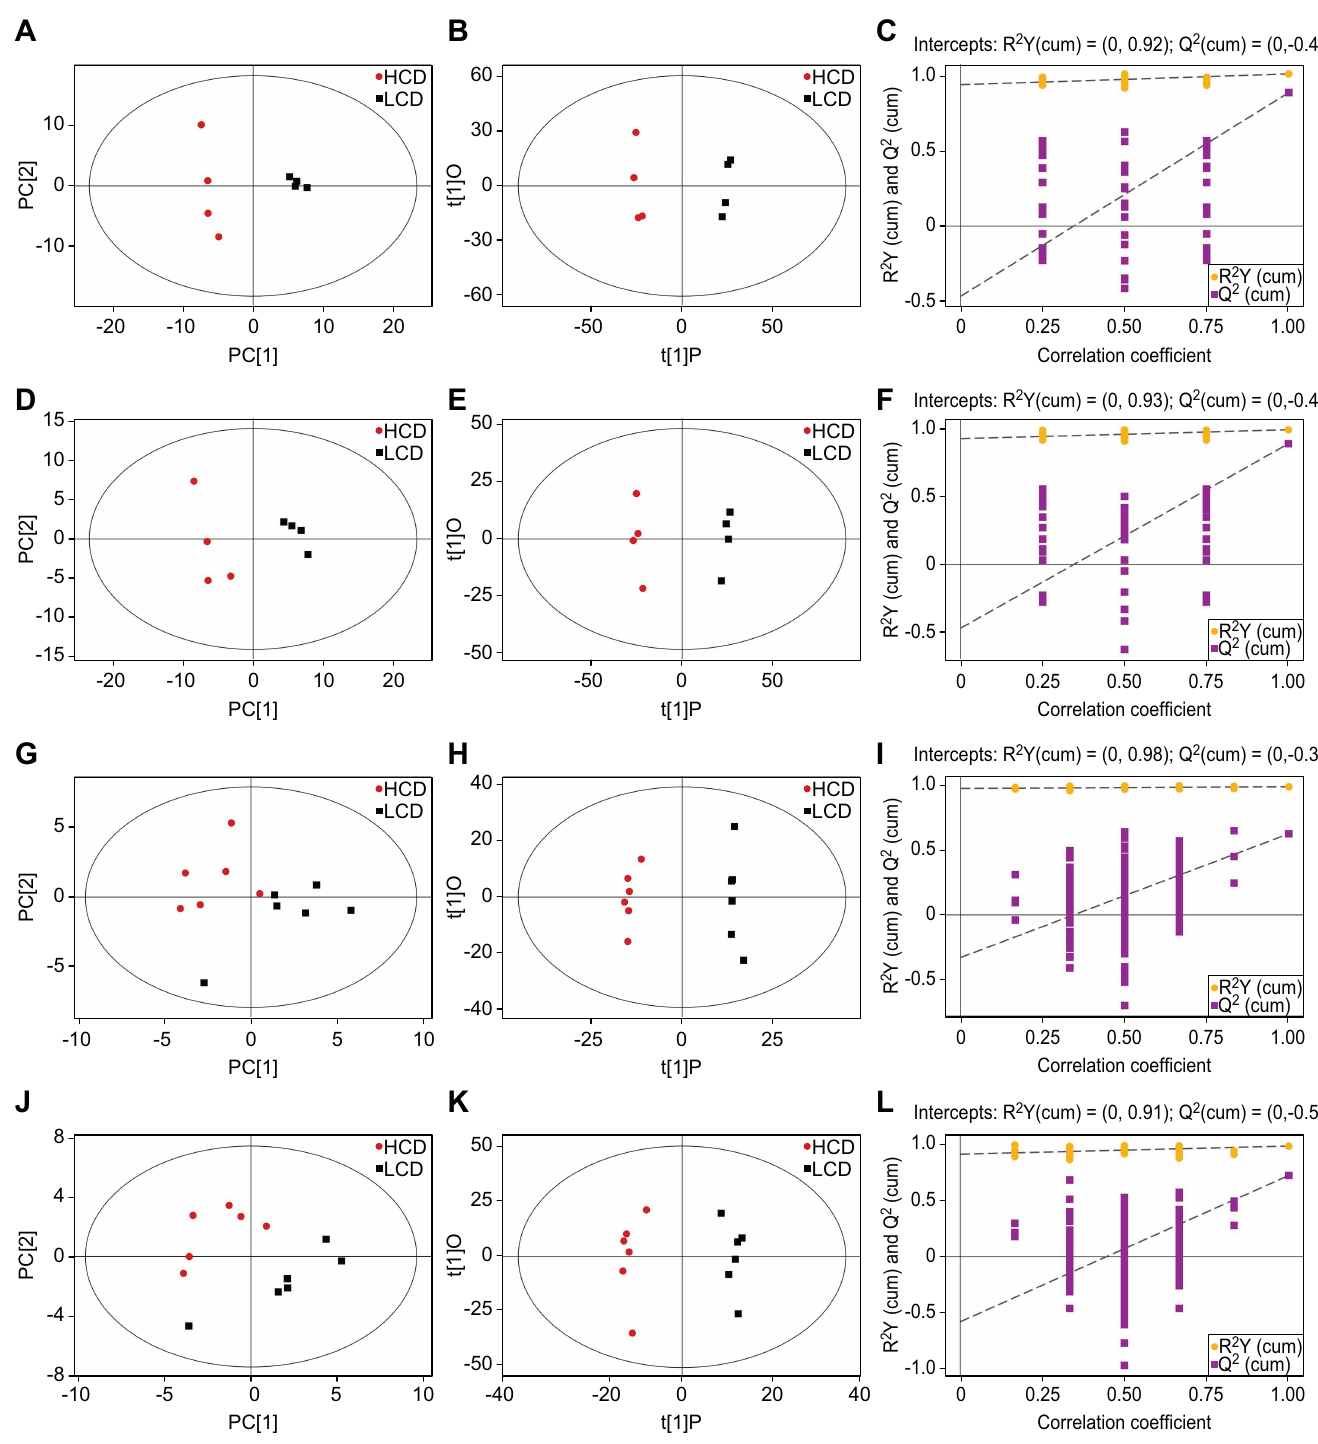
Fig 1. PCA model score scatter plot, OPLS-DA model and permutation test for the LCD vs . HCD groups. The PCA model (A, D, G and J), OPLS-DA model (B, E, H and K) and permutation test of the OPLS-DA model (C, F, I and L) were derived from the UHPLC-QTOF/MS metabolomics profiles of rumen and plasma for beef steers fed the low-corn diet (LCD) and the high-corn diet (HCD). A-C and D-F were respectively derived from POS and NEG for the rumen fluid, and G-I and J-L were respectively derived from POS and NEG for the plasma samples. Red and black respectively represent HCD and LCD administration to beef steers (A, B, D, E, G, H, J and K). Purple squares represent the Q 2 value, and yellow dots represent the R 2 value from the permutation test (C, F, I and